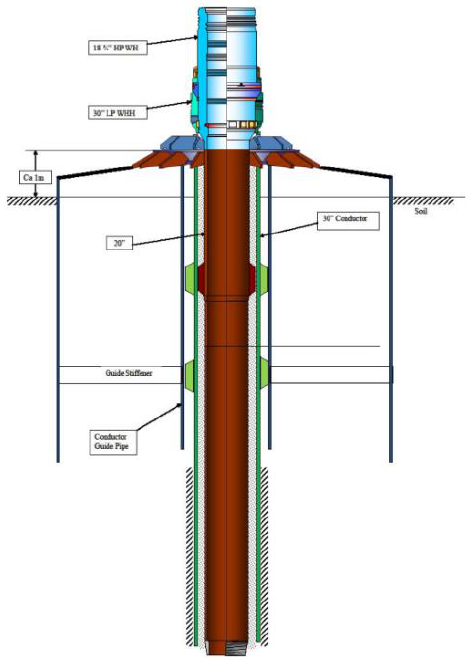
Figure 14. Surface well construction technology of suction anchor [This figure was modified with permission from ref. [169]. Copyright 2011, SPE].